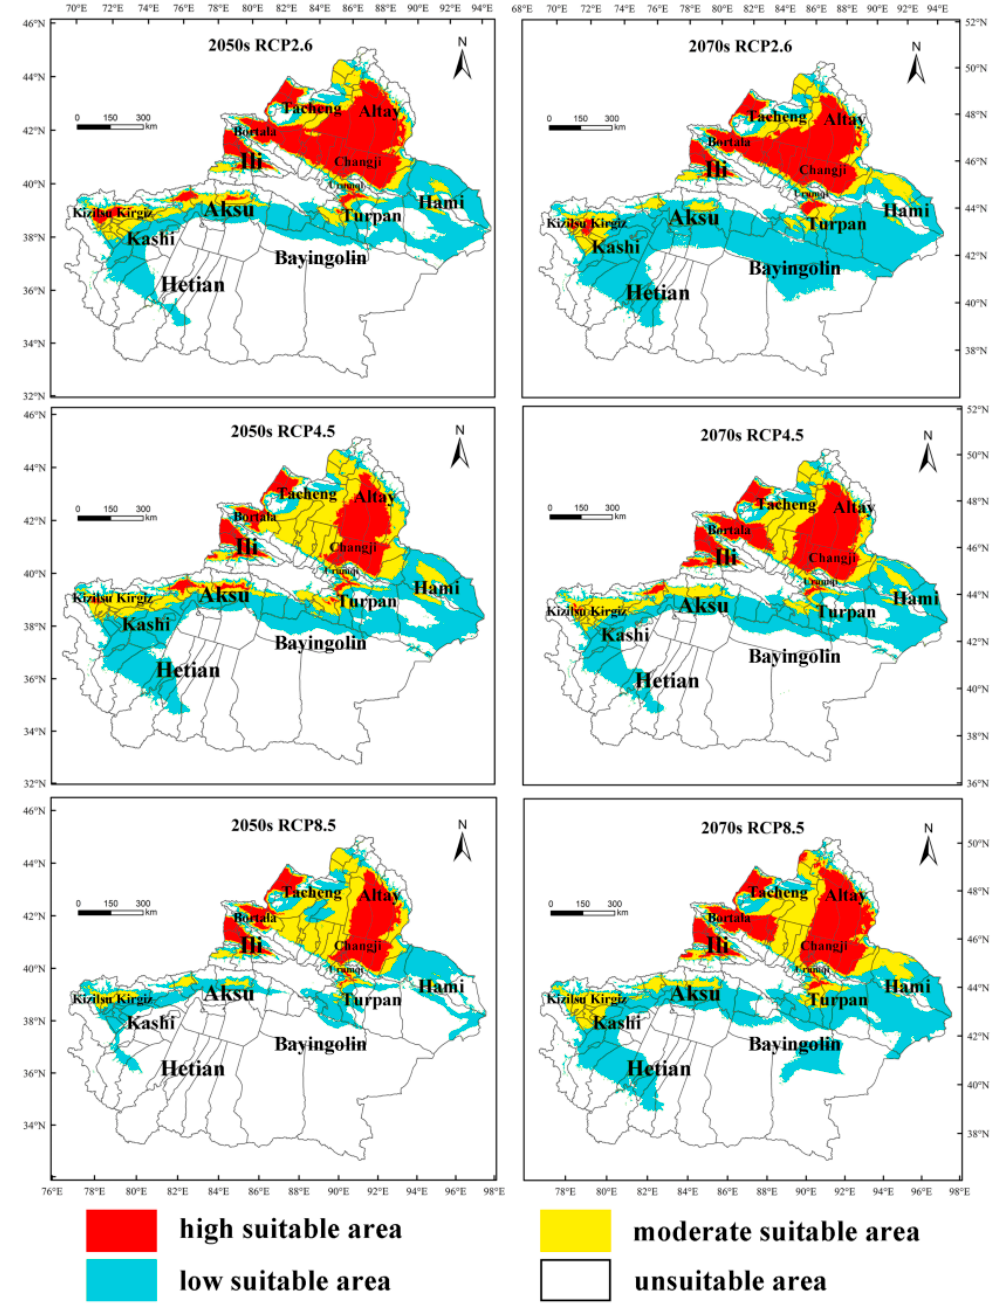
Figure 10. The predicted potential distribution area of M. destructor in Xinjiang, China, under three different climate scenarios in the future.